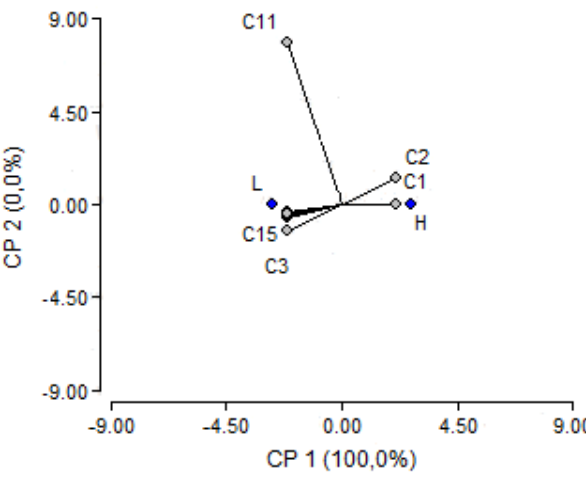
Figure 3. PCA where all identified compounds are classified according to low (L) and high (H) ORAC results.